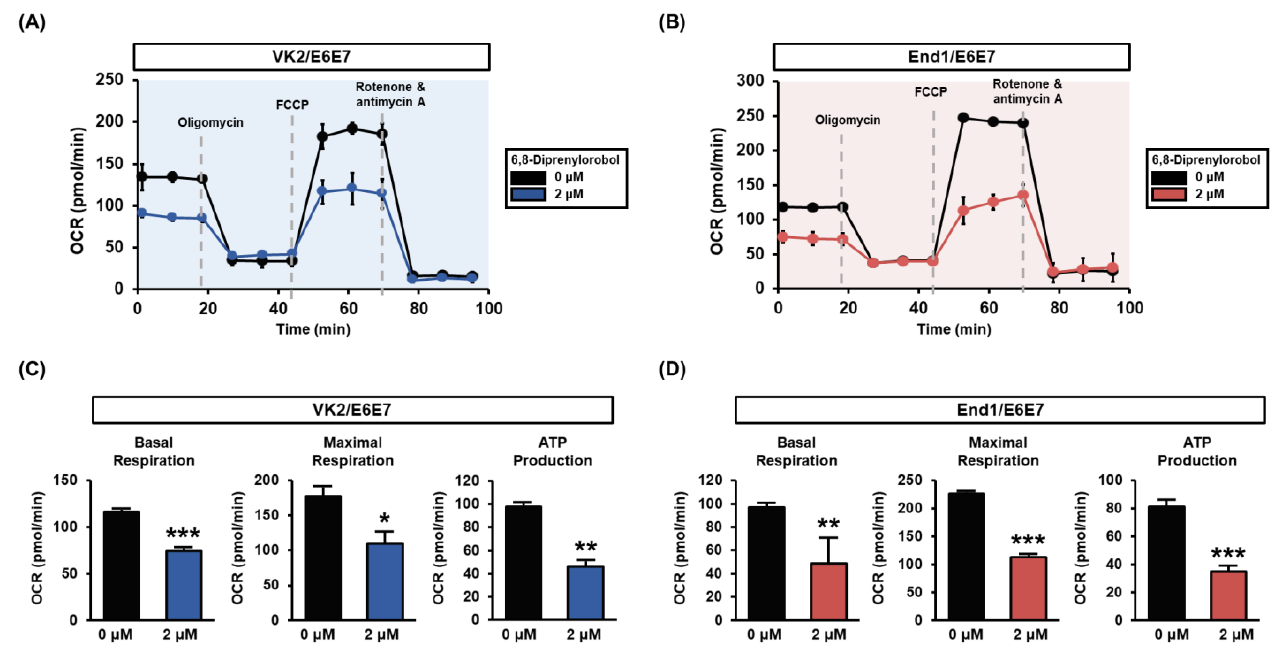
Figure 5. Effects of 6,8-diprenylorobol on mitochondrial respiration of VK2/E6E7 and End1/E6E7 cells. ( A , B ) Mitochondrial respiration was measured in VK2/E6E7 and End1/E6E7 with a Seahorse XFe analyzer. ( C , D ) Each part of basal respiration, maximal respiration, and ATP production between the vehicle and 6,8-diprenylorobol groups is indicated as a graph. Asterisks indicate significant levels between vehicle-treated cells and 6,8-diprenylorobol-treated cells (* p < 0.05, ** p < 0.01, and *** p < 0.001).